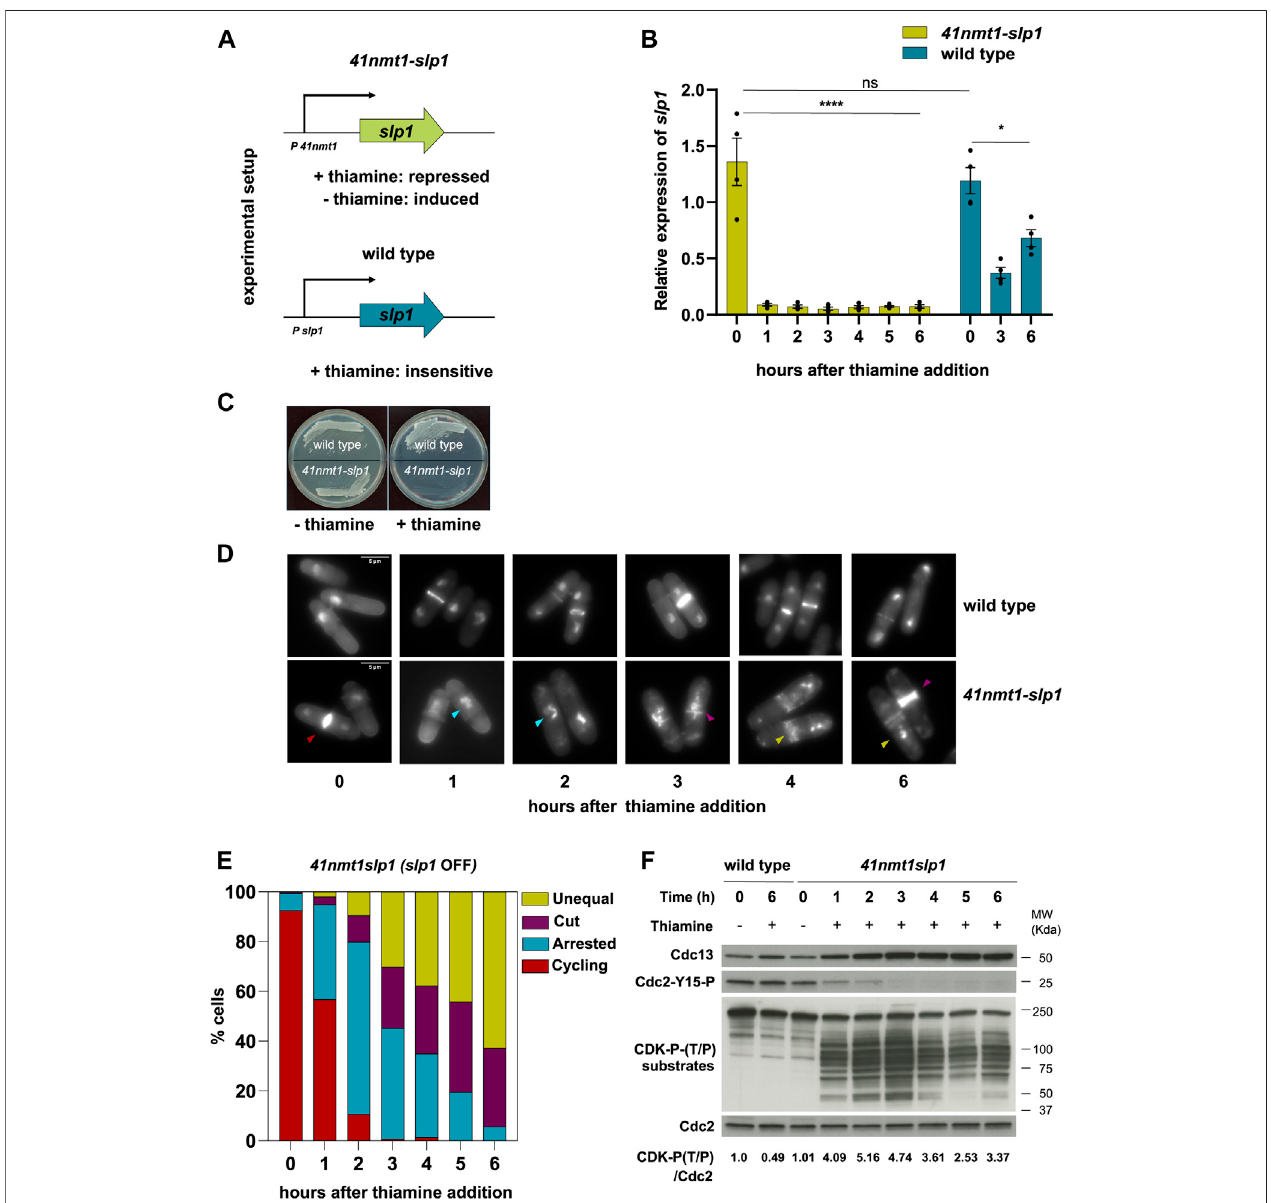
FIGURE 1 | Depletion of slp1 arrests cells in metaphase but cannot prevent cytokinesis. (A) Overview of the experimental setup used to repress the expression of slp1 underthecontrolof p41-nmt1 . Slp1 isrepressedinthepresenceof15 µMthiamine(+T)andexpressedintheabsenceofthiamine( − T).Wildtypecellswereusedas control for the endogenous expression of slp1. (B,D – F) cells were grown exponentially in EMM ( p41-nmt1 promoter induced) and shifted to EMM +T ( p41-nmt1 promoter repressed) at 30 ° C. Samples were collected at the indicated time points for mRNA expression, microscopy, and western blot. (B) mRNA expression of slp1 in wildtype and p41-nmt1:slp1 cells. Expression isrelative to actin and wasdetermined byqPCR. Meanand SEMoffour biological replicates are shown.Statistical signi fi cancewasdeterminedbyatwo-way ANOVAwithTukey ’ smultiplecomparisonstest. ns: p > 0.05;****: p ≤ 0.0001. (C) Imageofwildtypeandp41- nmt1:slp1 cells streaked on EMM agar plates that contain 15 µM thiamine or not at 30 ° C. (D) Images of ethanol- fi xed cells stained with DAPI to visualise DNA compactation and blankophor to visualise cell wall and septum by microscopy. In the lower panels, Differently-colored arrowheads indicate the different phenotypes scored in (E) : Cycling cells (red), metaphase-arrested cells with condensed chromosomes (cyan), cut cells (purple) and septated cells with unequal segregation of chromosomes (yellow). Scale bar 5 µm. (E) The percentage of cycling cells, metaphase-arrested cells, and arrested cells that underwent cytokinesis (cut or unequal) were determined at the indicated time points after the addition of thiamine to the culture. At least 200 cells were counted per time point. (F) Cdc13 levels, phosphorylation at T/P sites in CDK substrates and Cdc2 phosphorylated at Y15 served as indicators of CDK activity and were detected by western blot. Cdc2 (PSTAIR) was used as a protein loading control. The numbers under the western blot indicate CDK-substrate Phosphorylation (P-T/P) quanti fi cation relative to Cdc2.